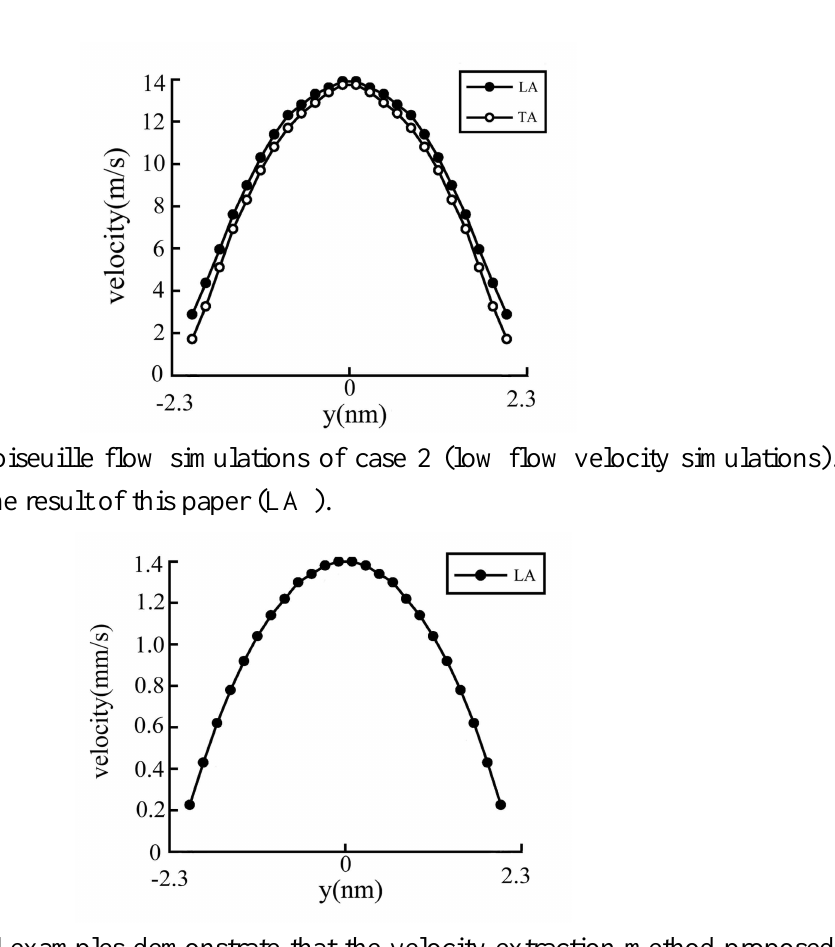
Figure 4 . Poiseuille flow simulations of case 2 (high flow velocity simulations). is the result of this paper (LA ). is the result of the traditional (TA) method.